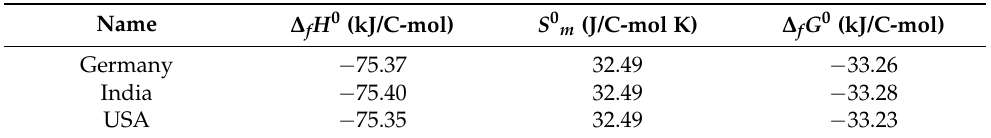
Table 3. Standard thermodynamic properties of the nucleocapsid live matter of the Omicron BA.2.75 subvariant. The table contains data on the standard enthalpy of formation, ∆ f H 0 , standard molar entropy, S 0 m , and standard Gibbs energy of formation, ∆ f G 0 .